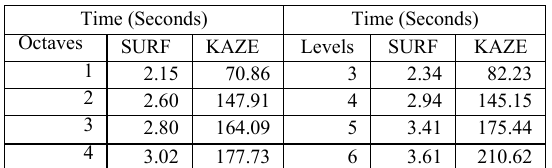
Table 4. Time taken per octave and per level for point detection